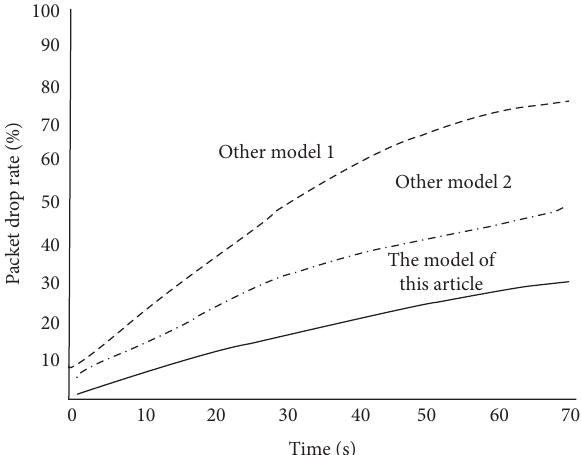
Figure 4: Comparison of packet switching rates of different models.